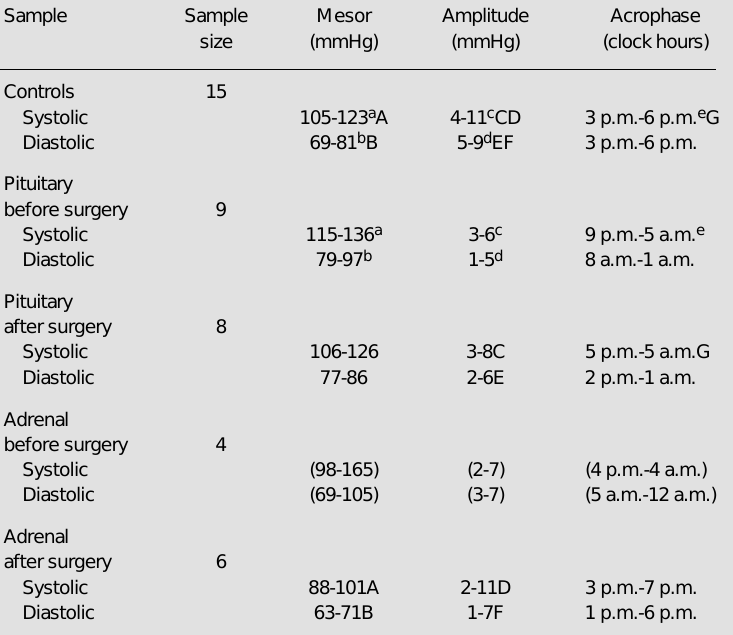
Table 2 - Lower-upper limits of the 95% confidence intervals (for the adrenal form of the syndrome before surgery, only the ranges are given) for chronobiological param- eters of blood pressure in control and Cushing samples. Significant differences between groups were determined by the Mann-Whitney test (a-a to e-e) and by the confidence intervals for the difference (A-A to G-G, Figure 1A,B). Values followed by the same letter differed significantly.